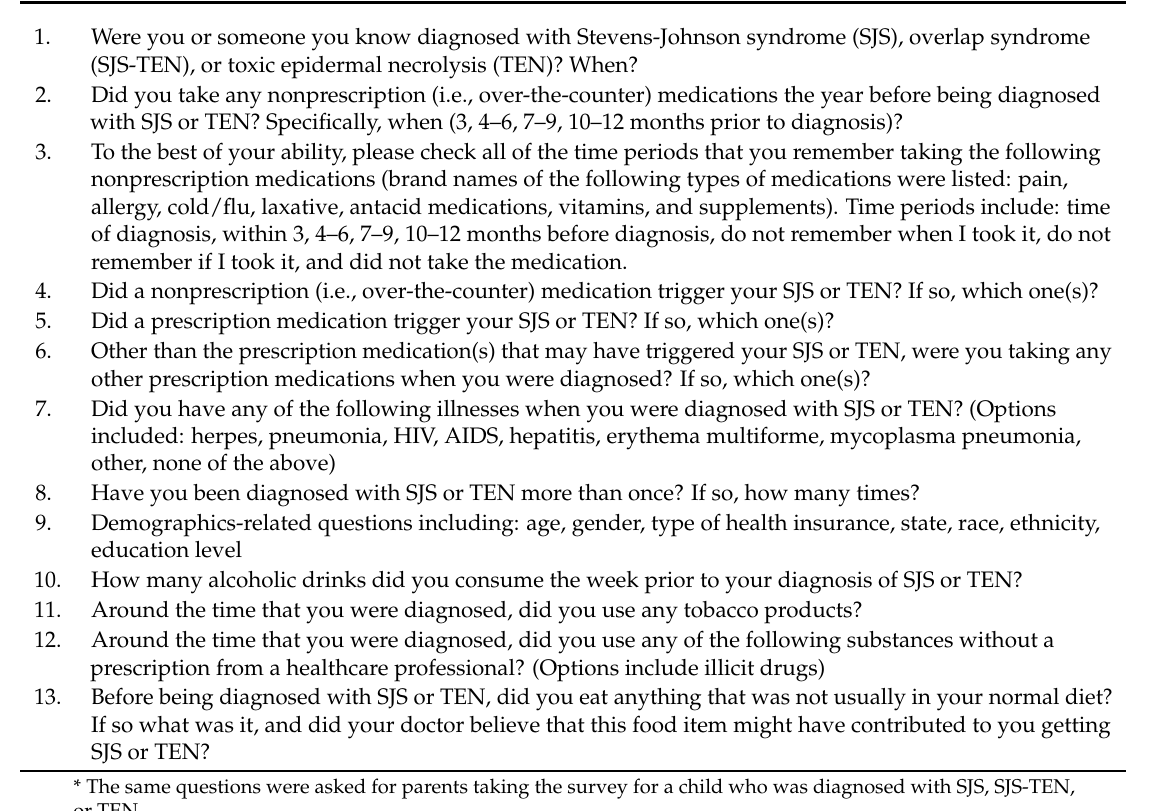
Table 1. High-level overview of questions asked in the survey